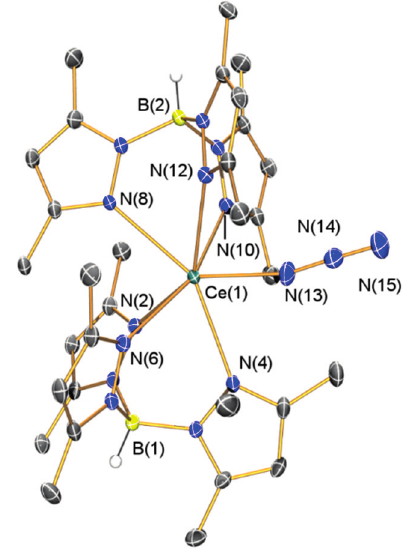
Figure 9. Molecular structure of 4 ·C 7 H 8 with selective atom labeling. Displacement ellipsoids set at 30% probability level and hydrogen atoms (except B–H) and lattice solvent omitted for